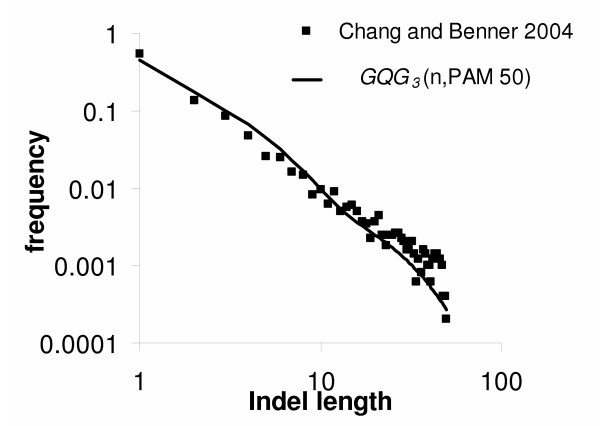
Comparison of the GQG distribution with the data obtained from the study [7] for protein sequences with less than 100 PAM sequence divergence. The parameters of the GQG disribution are set to the default c = 3 and t = PAM 50. These values were chosen simply because they seemed reasonable, not to maximize the fit of the curve to the data. The striking fit indicates that our scaling of the QG distribution is appropriate to model indels at lower levels of sequence divergence.